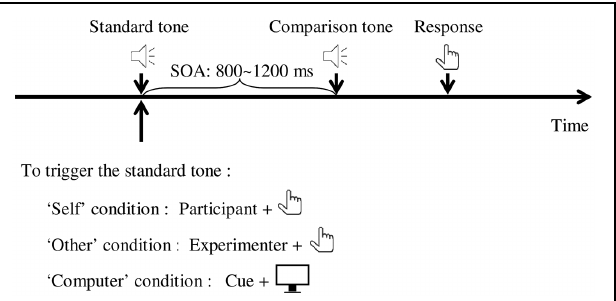
FIGURE 1 | Schematic illustration of a typical trial. The standard tone was triggered by participant (‘self’ condition), experimenter (‘other’ condition), or computer (‘computer’ condition). The comparison tone played automatically after an SOA of 800–1200 ms. Participants were instructed to respond as accurately as possible which tone was louder. SOA, stimulus onset